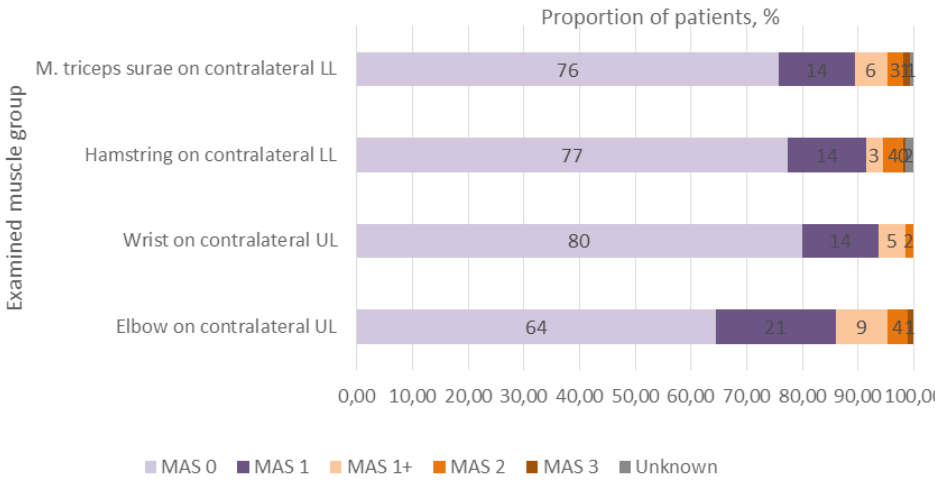
Fig. 1. Post-stroke spasticity in the cohort of examined patients at visit 1. UL, upper limb; LL, lower limb; MAS, modified Ashworth Scale